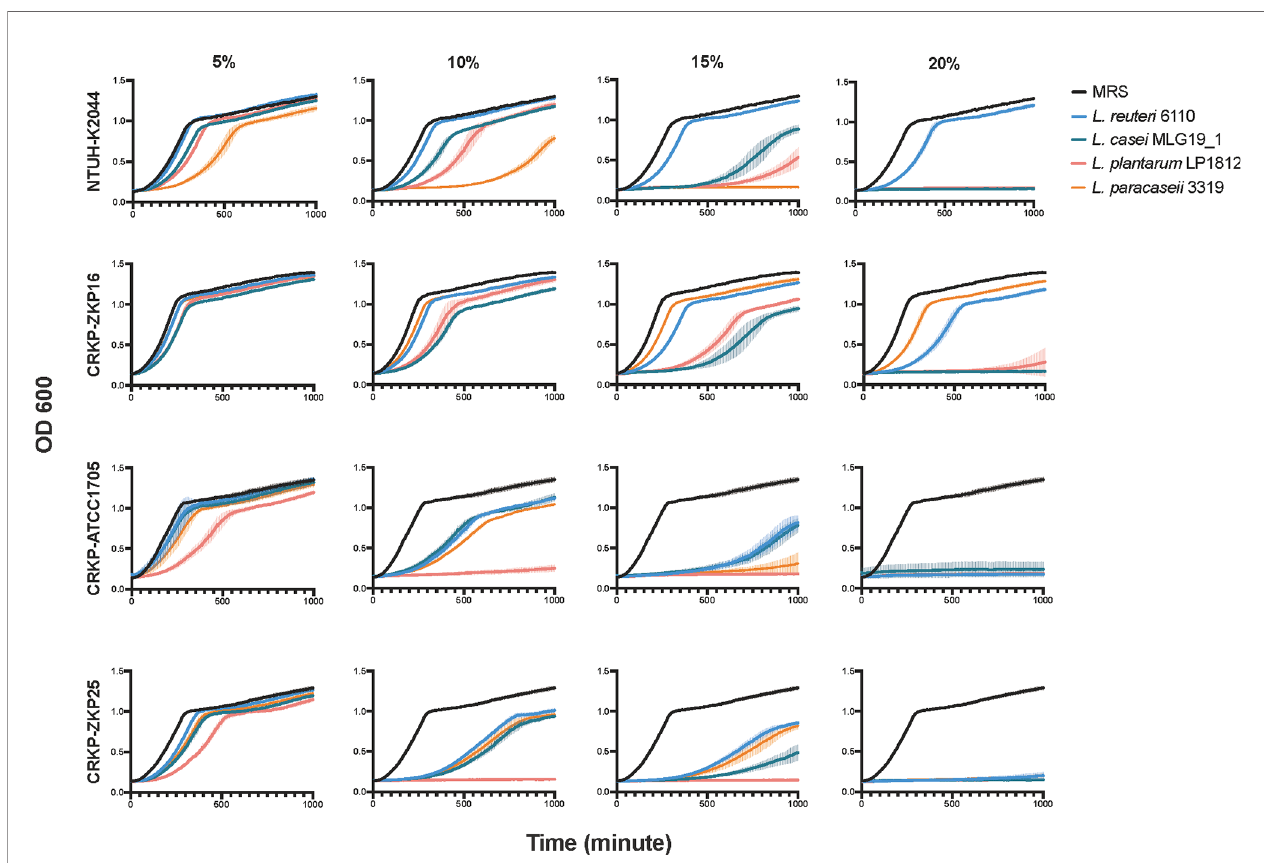
FIGURE 2 | The growth curves of K. pneumoniae in Lactobacillus spp. supernatants of different species and concentrations. The amount of K. pneumoniae was exhibited by variations in absorption values at